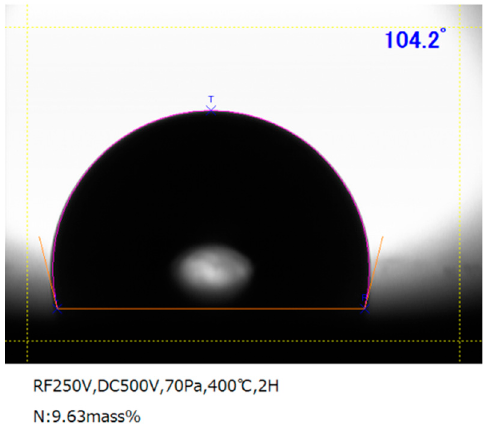
Figure 6. Measurement of the contact angle for a pure water droplet on the nitrided AISI316 surface.at 673 K for 7.2